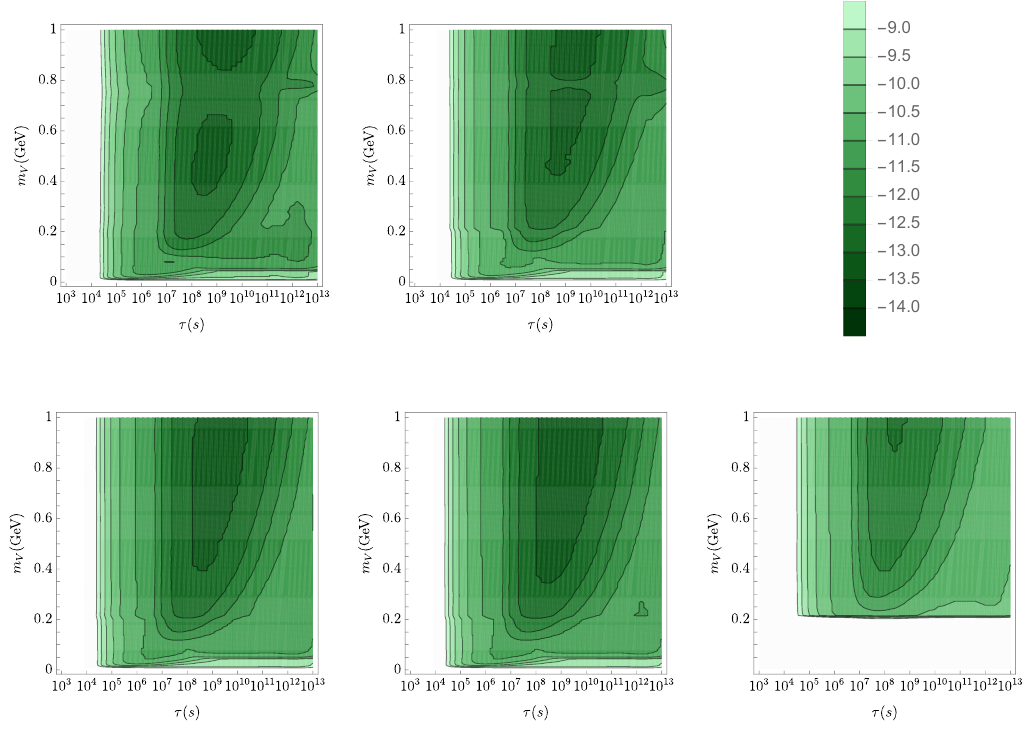
Figure 3 . BBN upper limits from electromagnetic e(cid:11)ects on the mass times yield log ( m V Y V = GeV) of sub-GeV dark vectors in the lifetime-mass plane for the dark vector species 10 DP (upper left), B (cid:0) L (upper middle), L e (cid:0) L (cid:22) (lower left), L e (cid:0) L (cid:28) (lower middle), and L (cid:22) (cid:0) L (cid:28) (lower right).